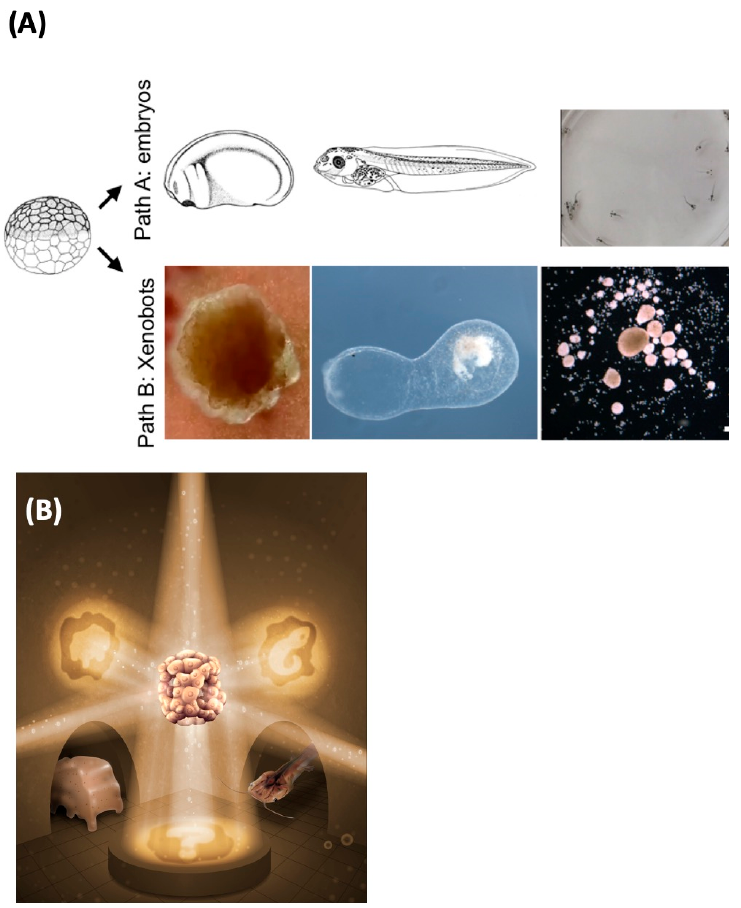
Figure 4. What does the Xenopus laevis genome specify? ( A ) The standard Xenopus laevis genome (in a frog egg) typically causes the construction of a set of standard embryonic stages (Path A) which results in tadpoles with specific behaviors. However, in a different context, the skin cells can autonomously create a Xenobot (Path B)—a spherical construct with autonomous motion, a different morphogenetic sequence, and behaviors such as kinematic self-replication. The same genomic information contains simultaneously seeds of emergent tadpoles or Xenobots. ( B ) Similar to the iconic cover image of the classic book Godel, Escher Bach [229] this image illustrates how the same hardware (the standard frog egg in the middle) can be used to generate diverse forms of living constructs. Different environments, external signals, and physiological events can coax diverse morphogenetic outcomes out of a constant biological information string (DNA). Images in ( A ) courtesy of Xenbase and Douglas Blackiston, Levin lab. Image in ( B ) by Jeremy Guay of Peregrine Creative.